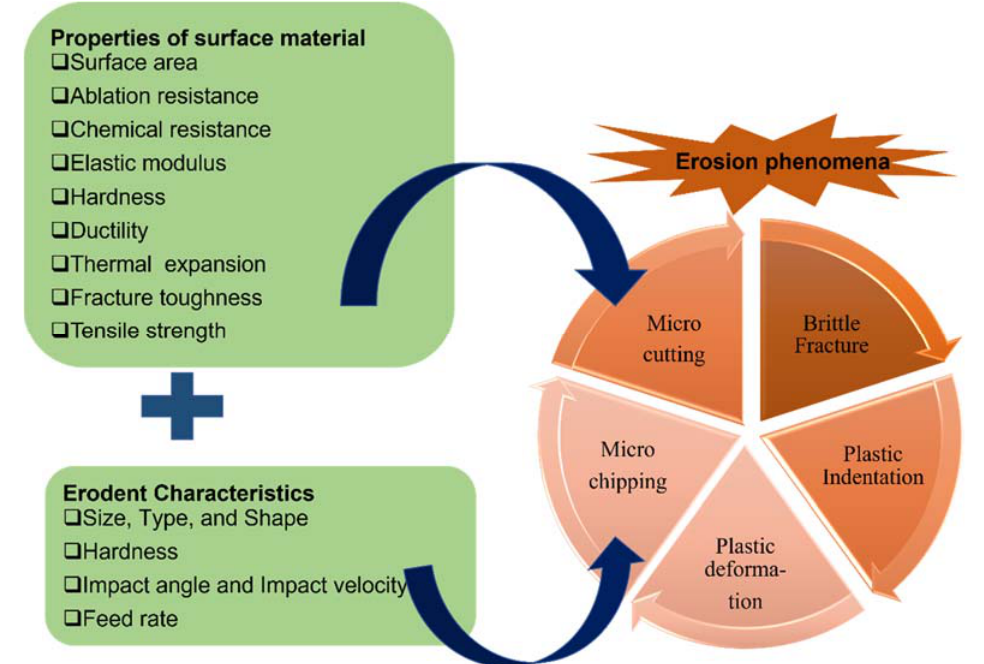
Figure 2. Factors governing erosion phenomena.